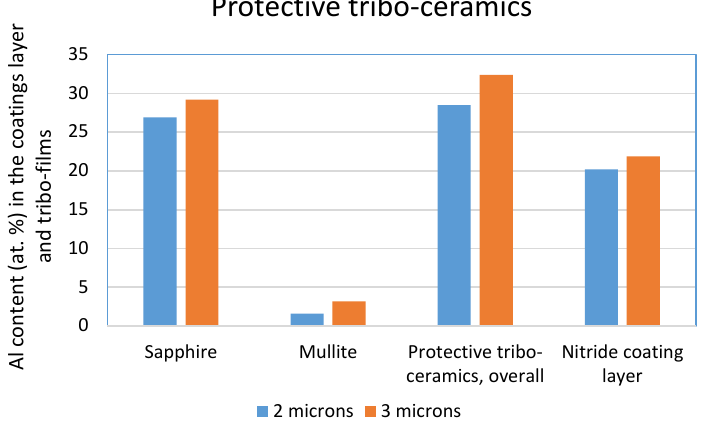
Figure 10. XPS (X-ray photoelectron spectroscopy, Physical Electronics (PHI) Quantera II spectrometer, Physical Electronics, Inc, Chanhassen, MN, USA) data for tribo-films formed on the worn surface of bi-multilayer TiAlCrSiYN/TiAlCrN thin film coating with different thickness (of 2 and 3 µm) during running-in stage (after machining of 30 m).